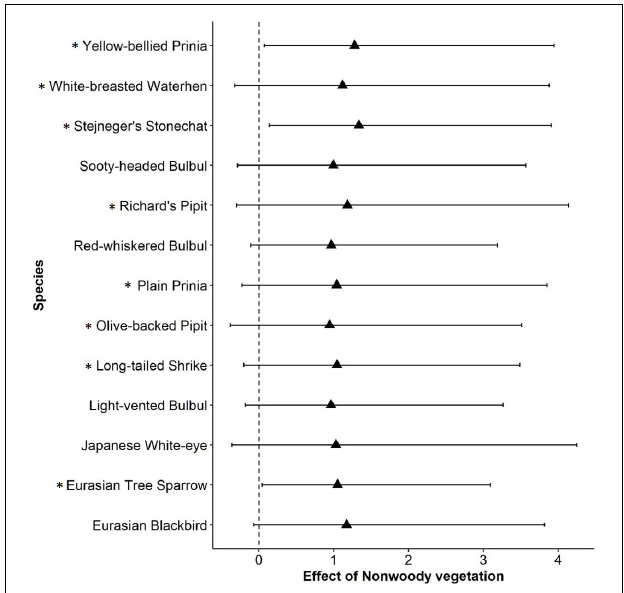
FIGURE 2 | Species-level responses generated from multi-species occupancy model. The estimate is on the logit scale, that is, the value is not back-transformed. Species whose 95% Bayesian credible intervals (error bars on the graph) did not cross 0 or slightly overlapped with 0 are shown. Asterisk (*) indicates open habitat species (grassland species, early successional species, and other species preferring open